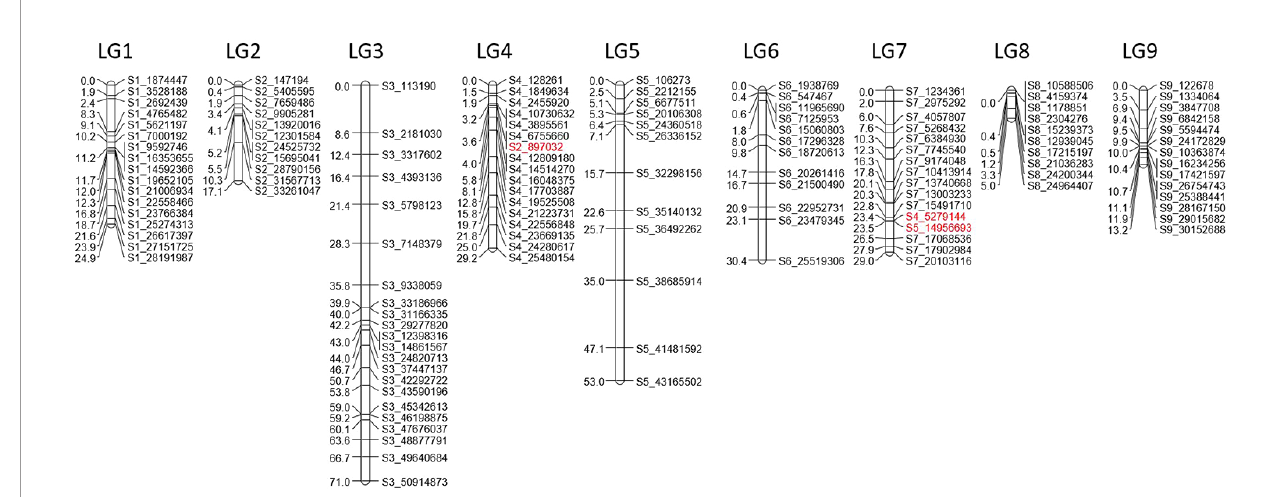
FIGURE 5 | Genetic map of the ‘ Giant Key ’ lime. Red SNPs are the non syntenic